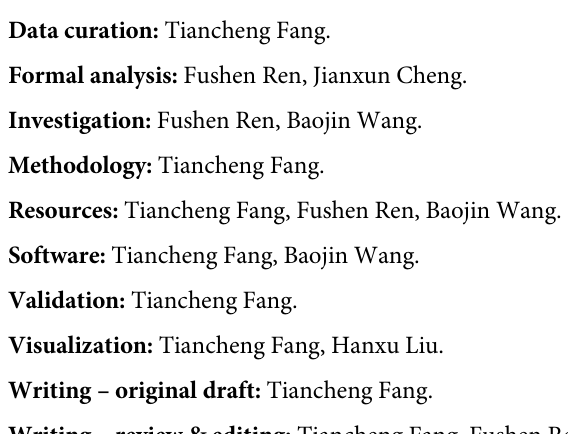
S1 Table. The parameters of particle and waterjet. S2 Table. The model parameters of rock damage simulation. S3 Table. The experimental